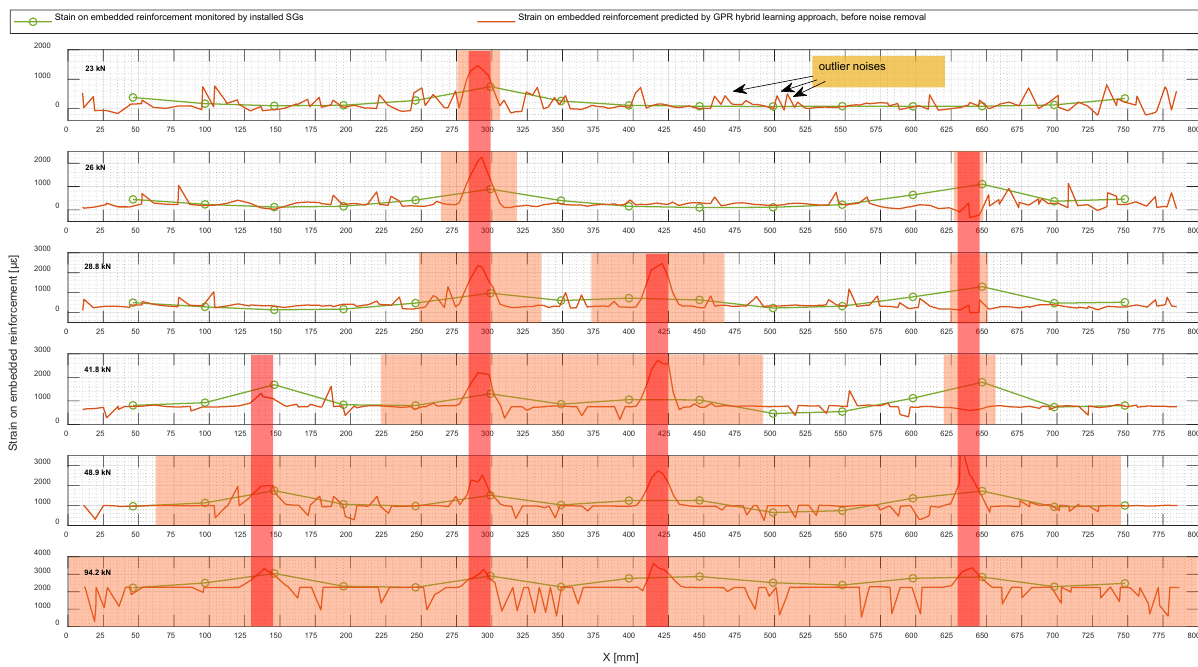
Figure 19. Predicted strain by hybrid learning approach on embedded reinforcement for 2N100 alongside that obtained by monitoring the installed SGs.